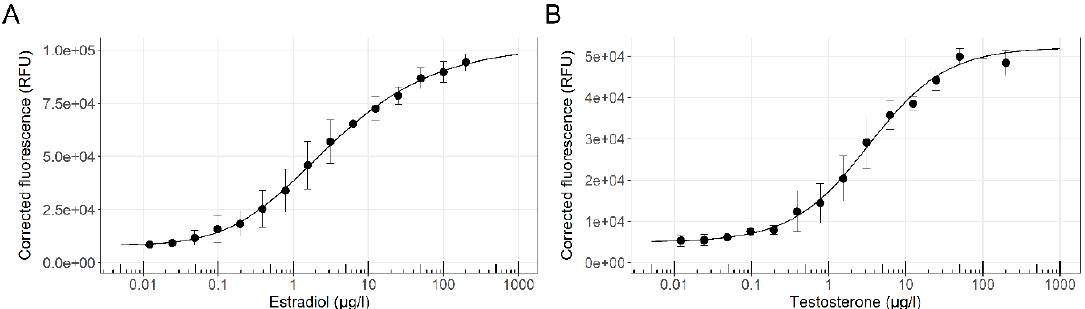
Figure 2. Dose-response curves of two fluorescent bioreporters. ( A ) Response of strain ER-Ruby to β -Estradiol (E2; 0.0122–200 μ g/L); ( B ) Response of strain AR-BFP to testosterone (0.0122–200 μ g/L). Estrogenic and androgenic activities were determined after an incubation time of 18 h at 30 °C. Corrected fluorescence values were calculated as detailed in Materials and Methods (Section 2.4), and the error bars show the respective standard errors. The solid line was fitted to the data using a five-parameter log-logistic function.